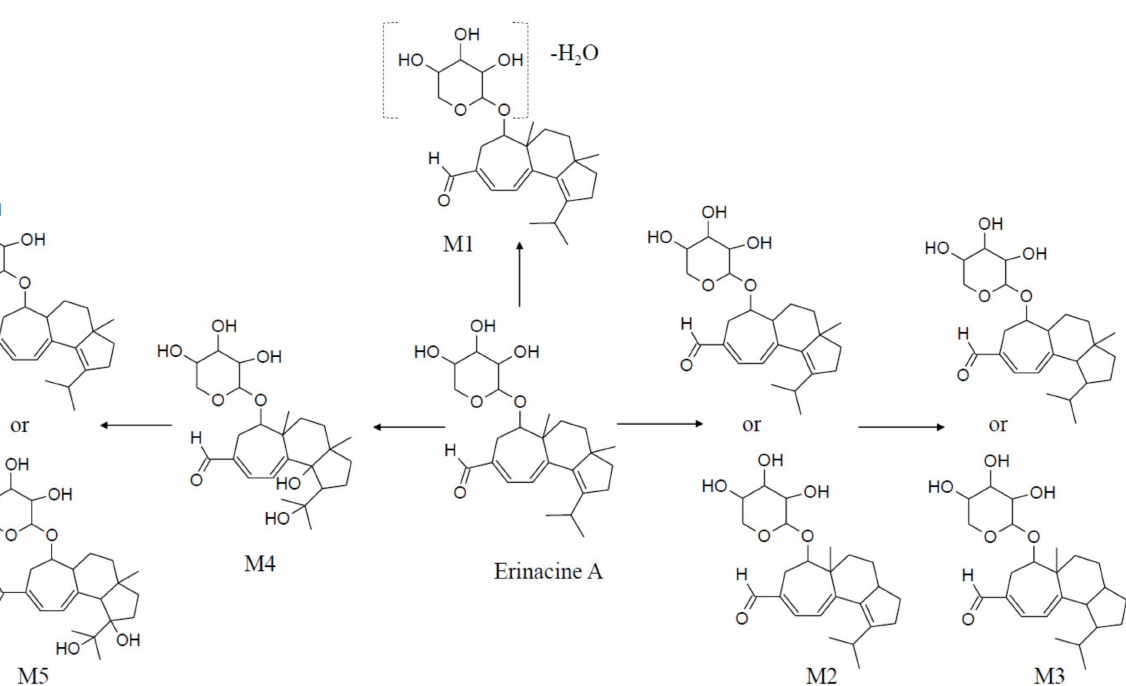
Figure 2. Proposed metabolic pathway of erinacine